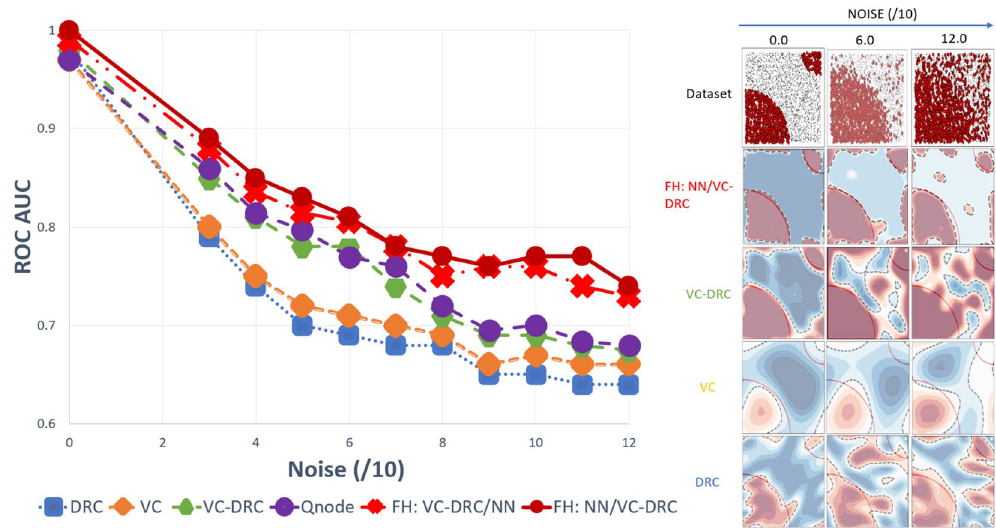
Figure 3. (Left) AUC–ROC curve for DRC, VC and VC–DRC classifiers for different noise levels. (Right) Prediction grids for respective classifiers for different noise